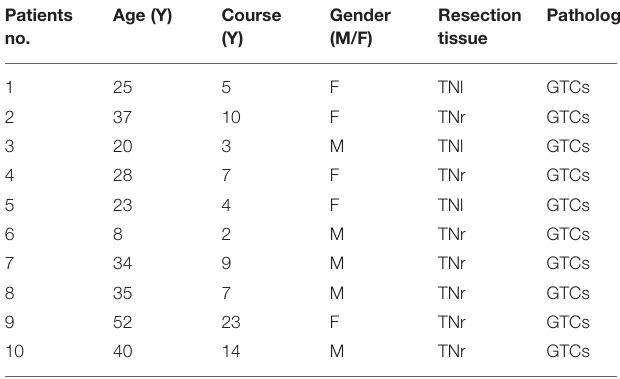
TABLE 1 | Clinical characteristic of TLE patients. Patients no.